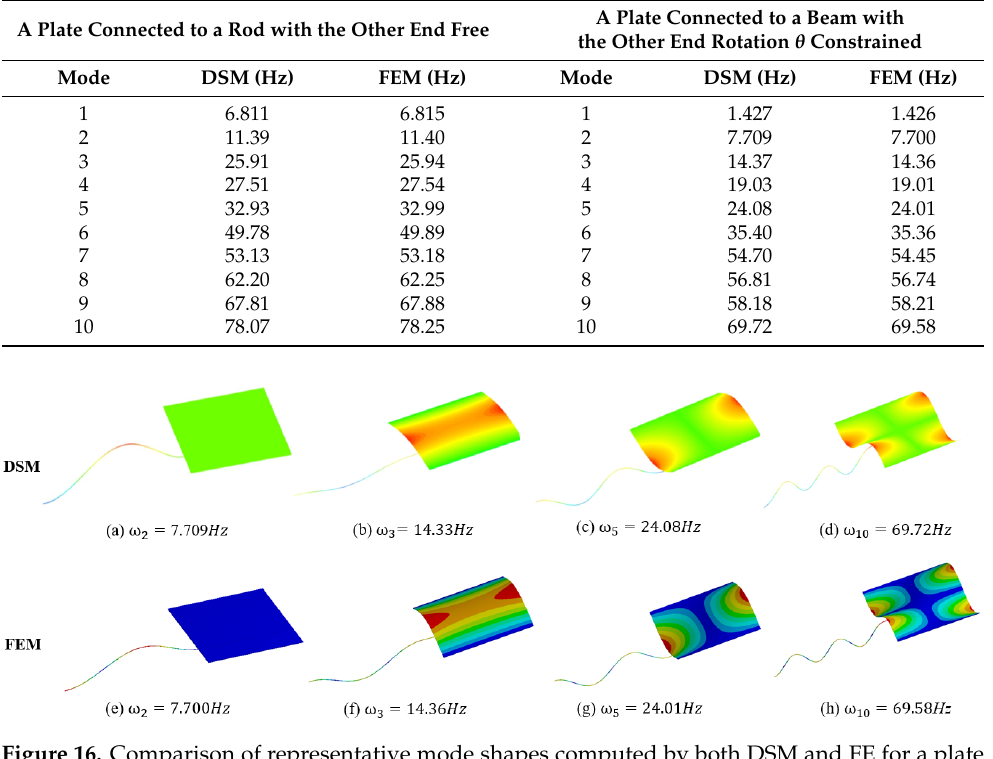
Table 3. The first 10 natural frequencies for the plate connected to a rod and/or a beam shown in Figure 15.